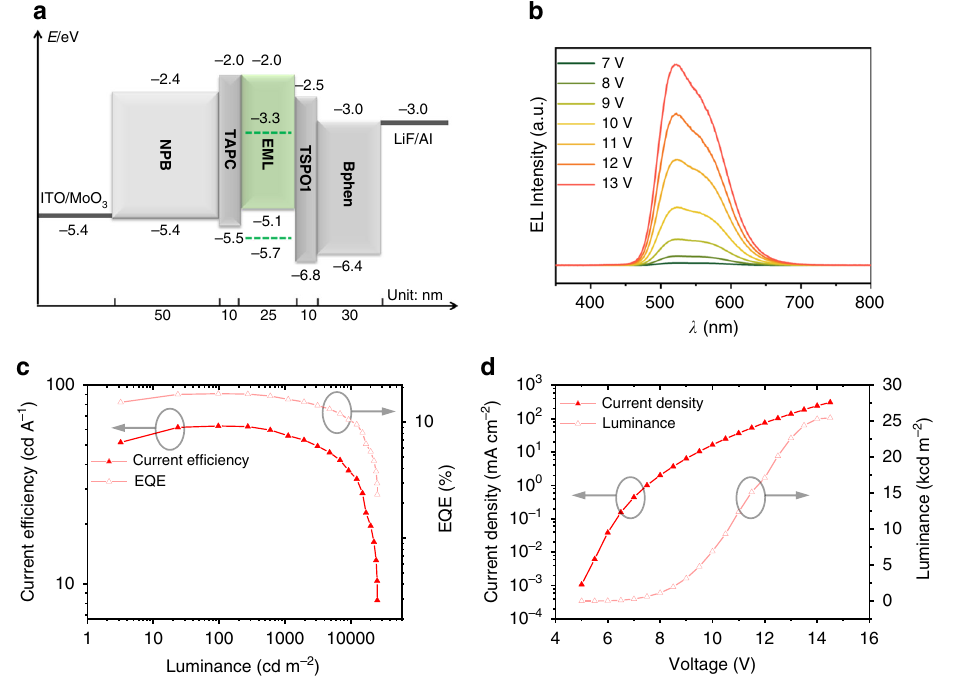
Fig. 4 The device structure and electroluminescence properties of Eu X 2 -N 8 compounds. a The optimized OLEDs device structure with frontier orbital energy levels of all organic materials and corresponding thickness. The HOMO and LUMO level of EuI 2 – N 8 are noted as green dash lines in the EML. b Electroluminescence spectra of the champion device at varying voltage from 7 V to 13 V. c Current ef fi ciency – luminance – external quantum ef fi ciency (CE – L – EQE) curve of the champion device. d Current density – voltage – luminance (J – V – L) curve of the champion